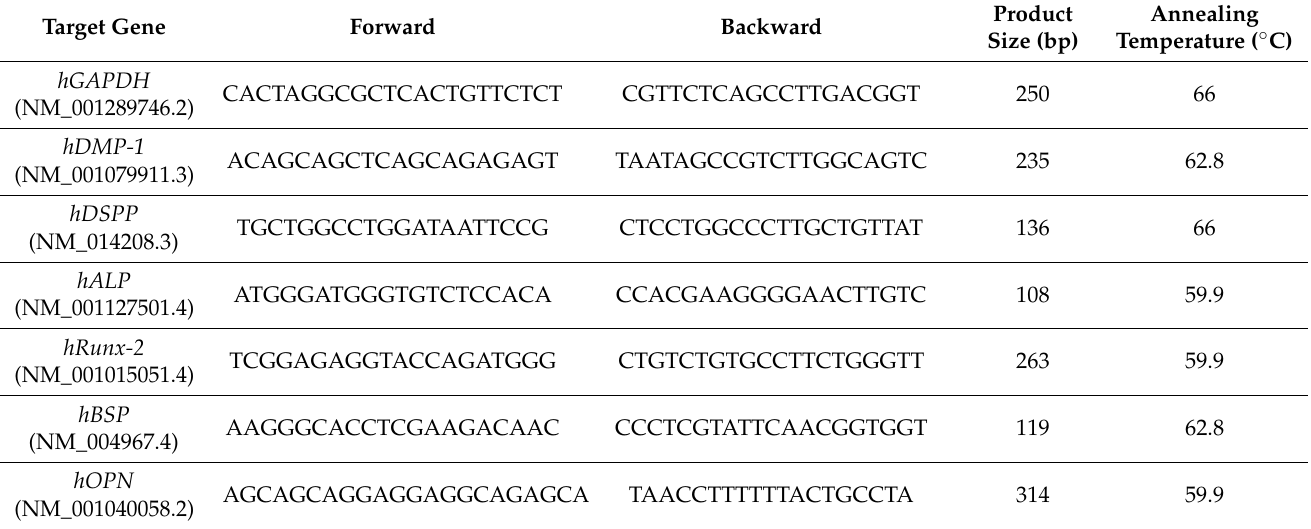
Table 1. Human primer information for real time RT-PCR.